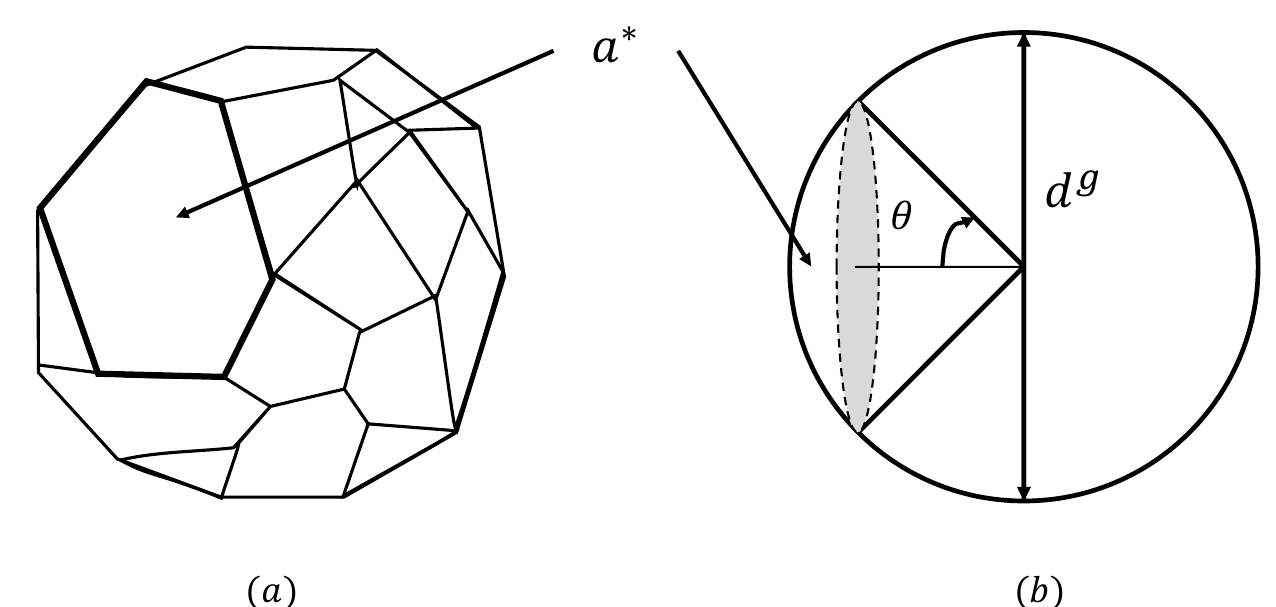
Figure 11. A schematic of ( a ) the grain boundary surface on an equiaxed grain: each facet corresponding to a boundary and ( b ) partial grain boundary area of a spherical grain, which is assigned the relevant area a ∗ , data from